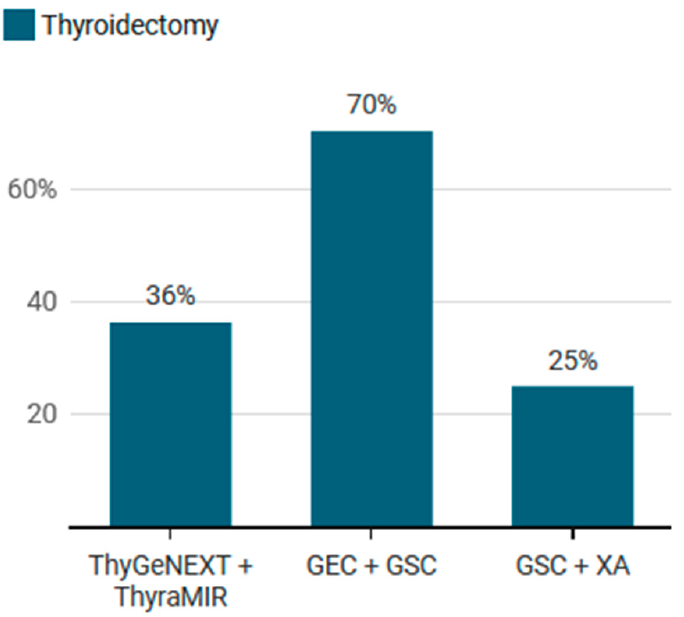
Figure 3. Frequency of nodules undergoing thyroidectomy sub-grouped by genetic testing platform. Table 3. Diagnostic accuracy of nodules with available surgical pathology undergoing the Thy- GeNEXT + ThyraMIR, GEC + GSC, and GSC + XA molecular testing.